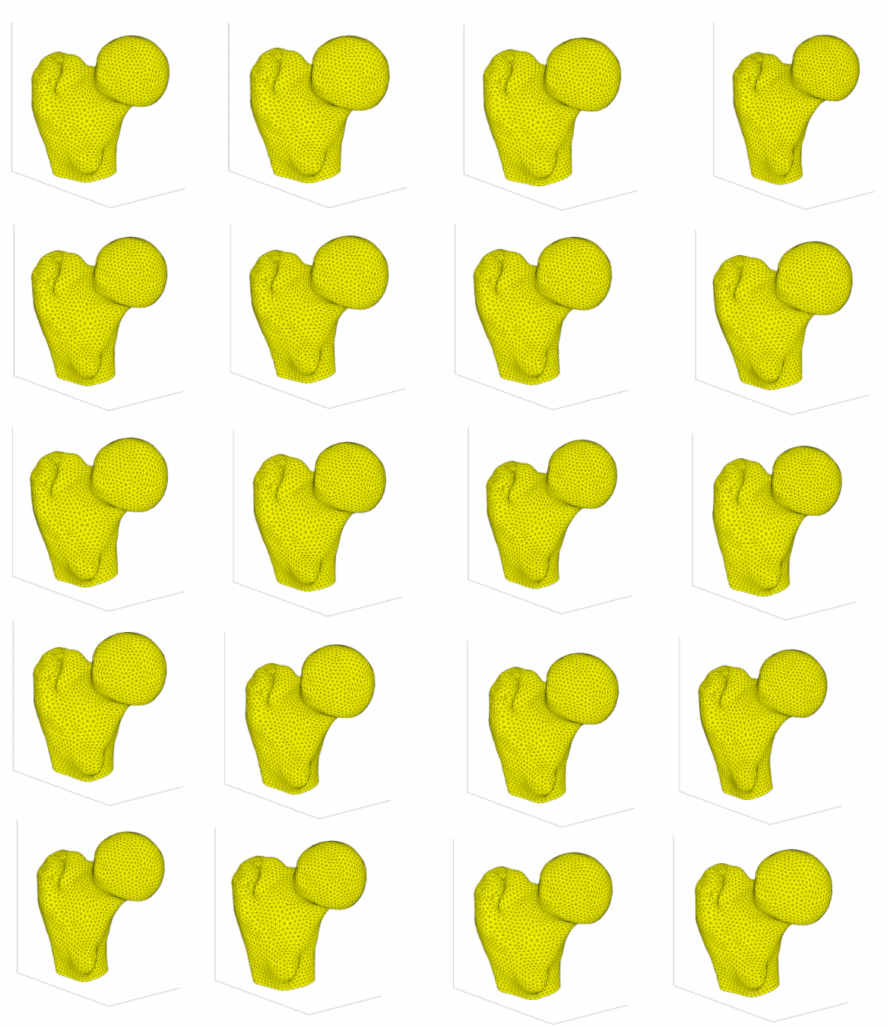
Figure 7. New set of 20 femurs, generated through inverse transform sampling, applied on empirical cumulative weight distribution of weights for each